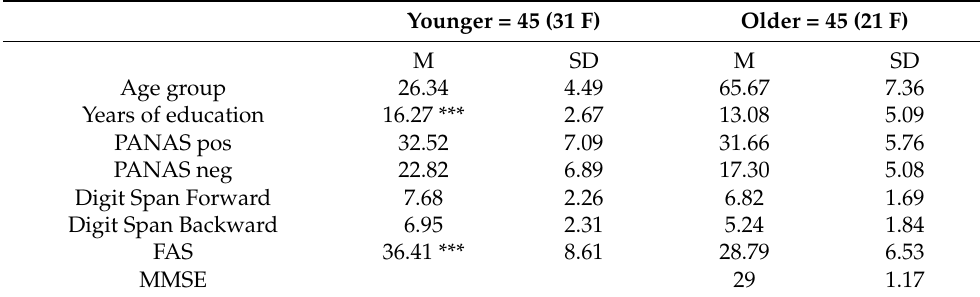
Table 1. Neuropsychological and demographic